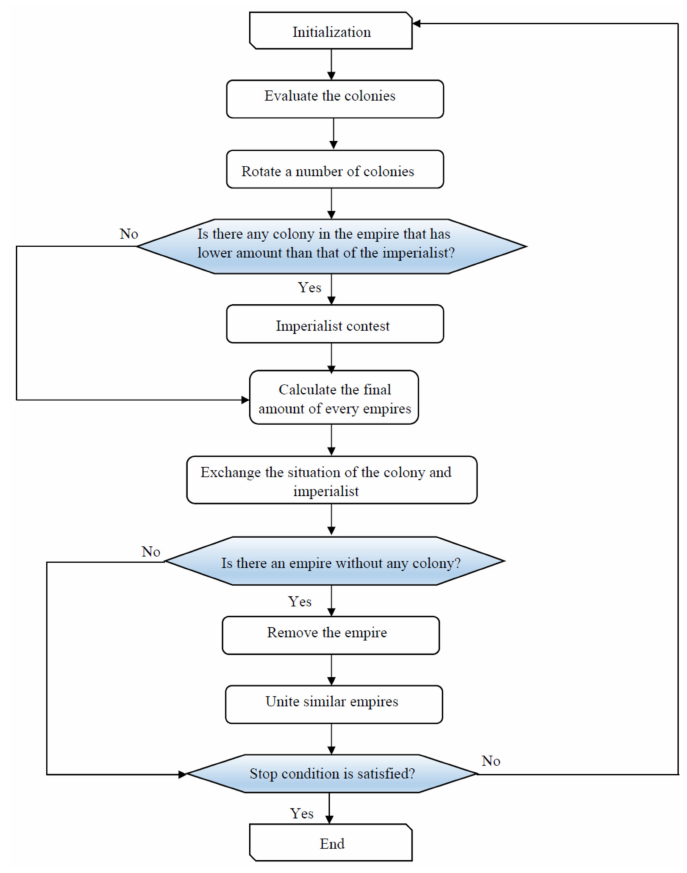
Figure 6. Flowchart to implement imperialist competitive algorithm